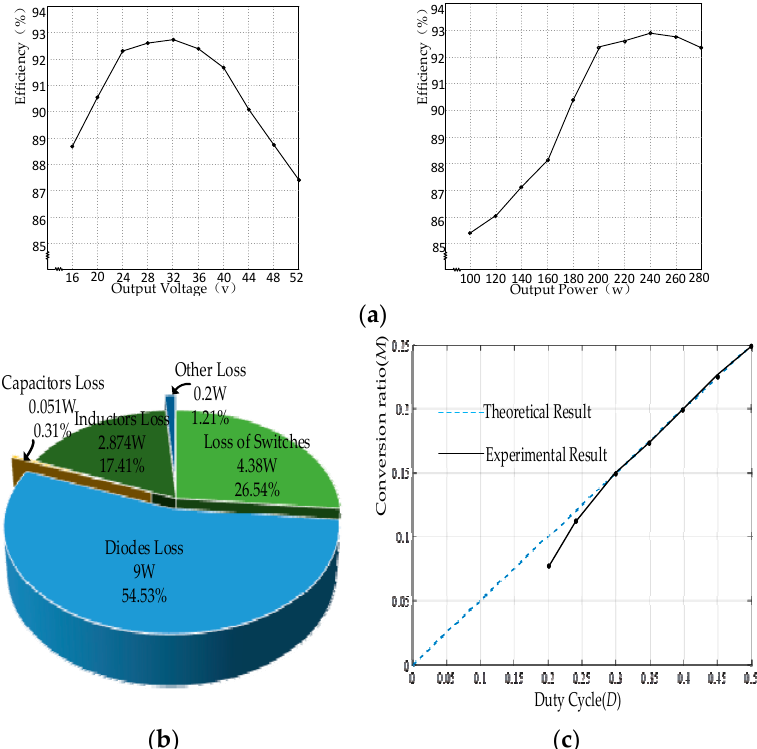
Figure 14. Charging mode (Buck): ( a ) efficiency curves of the prototype; ( b ) loss distribution of the prototype; ( c ) conversion ratio ( M ) vs. duty cycle ( D ) graph.